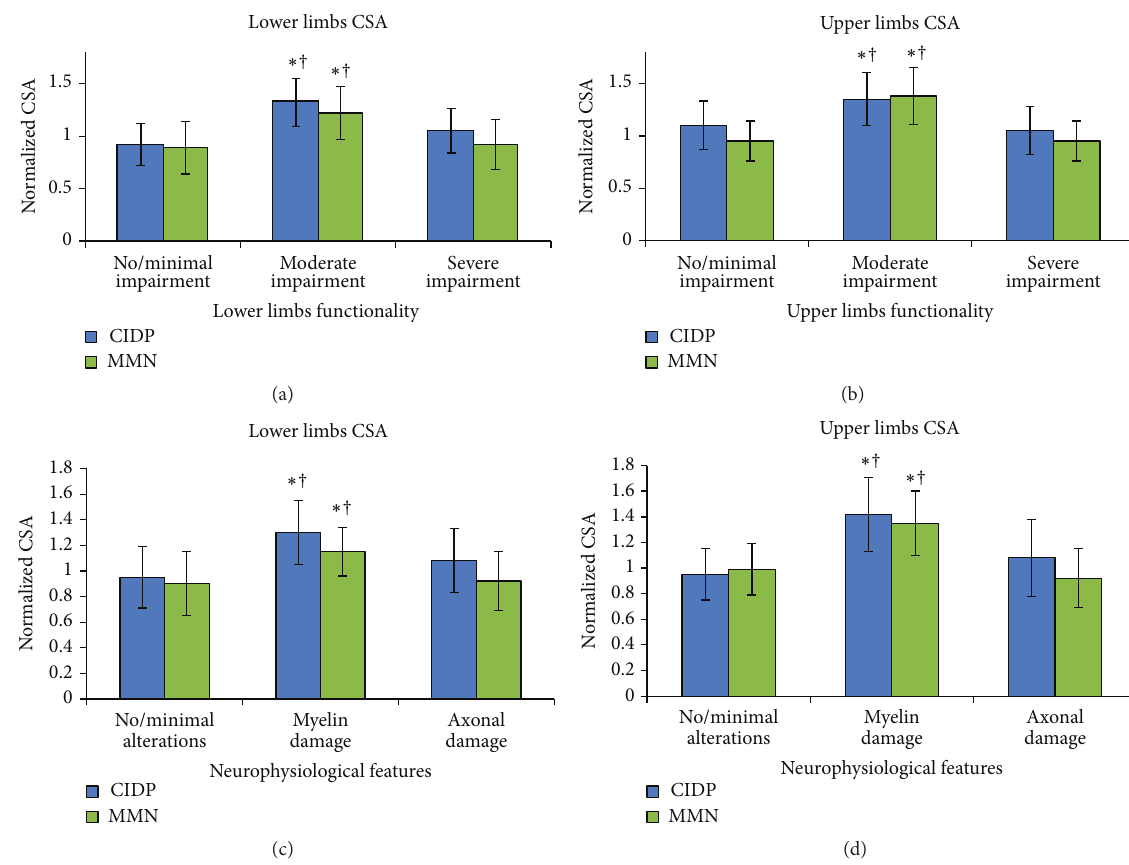
Figure 1: CSA values in relation to functional disability and neurophysiological alterations. Higher CSA values were observed in patients with intermediate functional disability and in nerves with predominant demyelinating features, both at the lower (a, c) and at the upper (b, d) limbs. Normalized cross-sectional area (CSA NORM ) = maximal CSA of the nerve/upper threshold (UT) of the CSA normality range of the nerve (CSA NORM = CSA max /CSA UT ). ∗ Significant difference ( 𝑝 < 0.05 ) versus “no/minimal impairment” (a, b) or “no/minimal alterations” (c, d). † Significant difference ( 𝑝 < 0.05 ) versus “severe impairment” (a, b) or “axonal damage” (c, d). No/minimal impairment: INCAT = 0 (lower limbs) or 0-1 (upper limbs). Moderate impairment: INCAT = 1-2 (lower limbs) or 2 (upper limbs). Severe impairment: INCAT = 3–5 (lower and upper limbs).